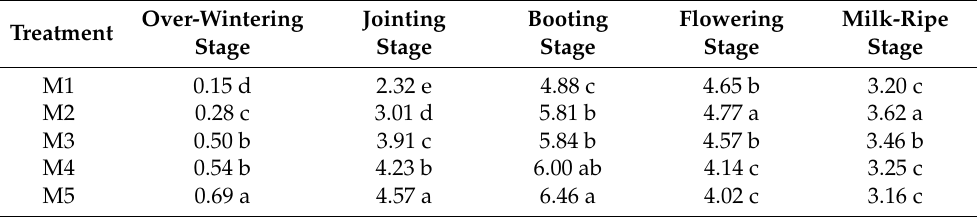
Table 5. Effects of plant density on leaf area index (LAI).